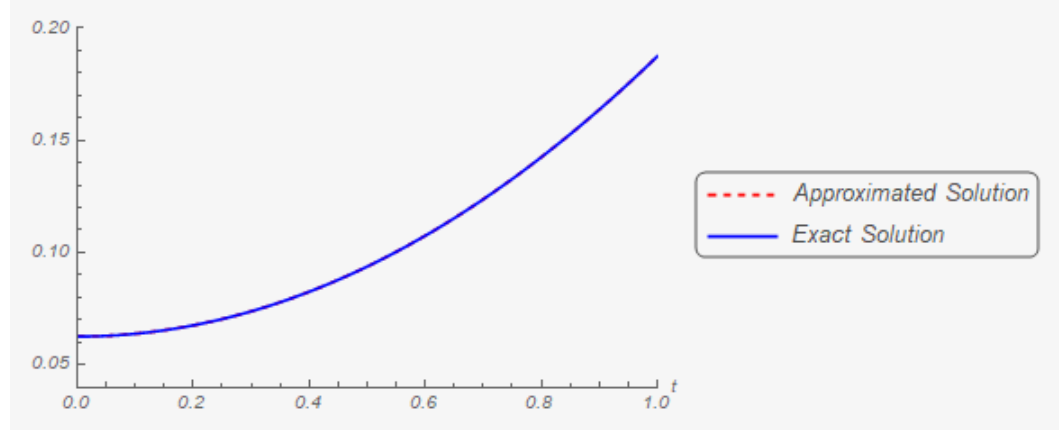
Figure 15. The first component of the exact solution and its three hundred and sixty-fourth approximation.